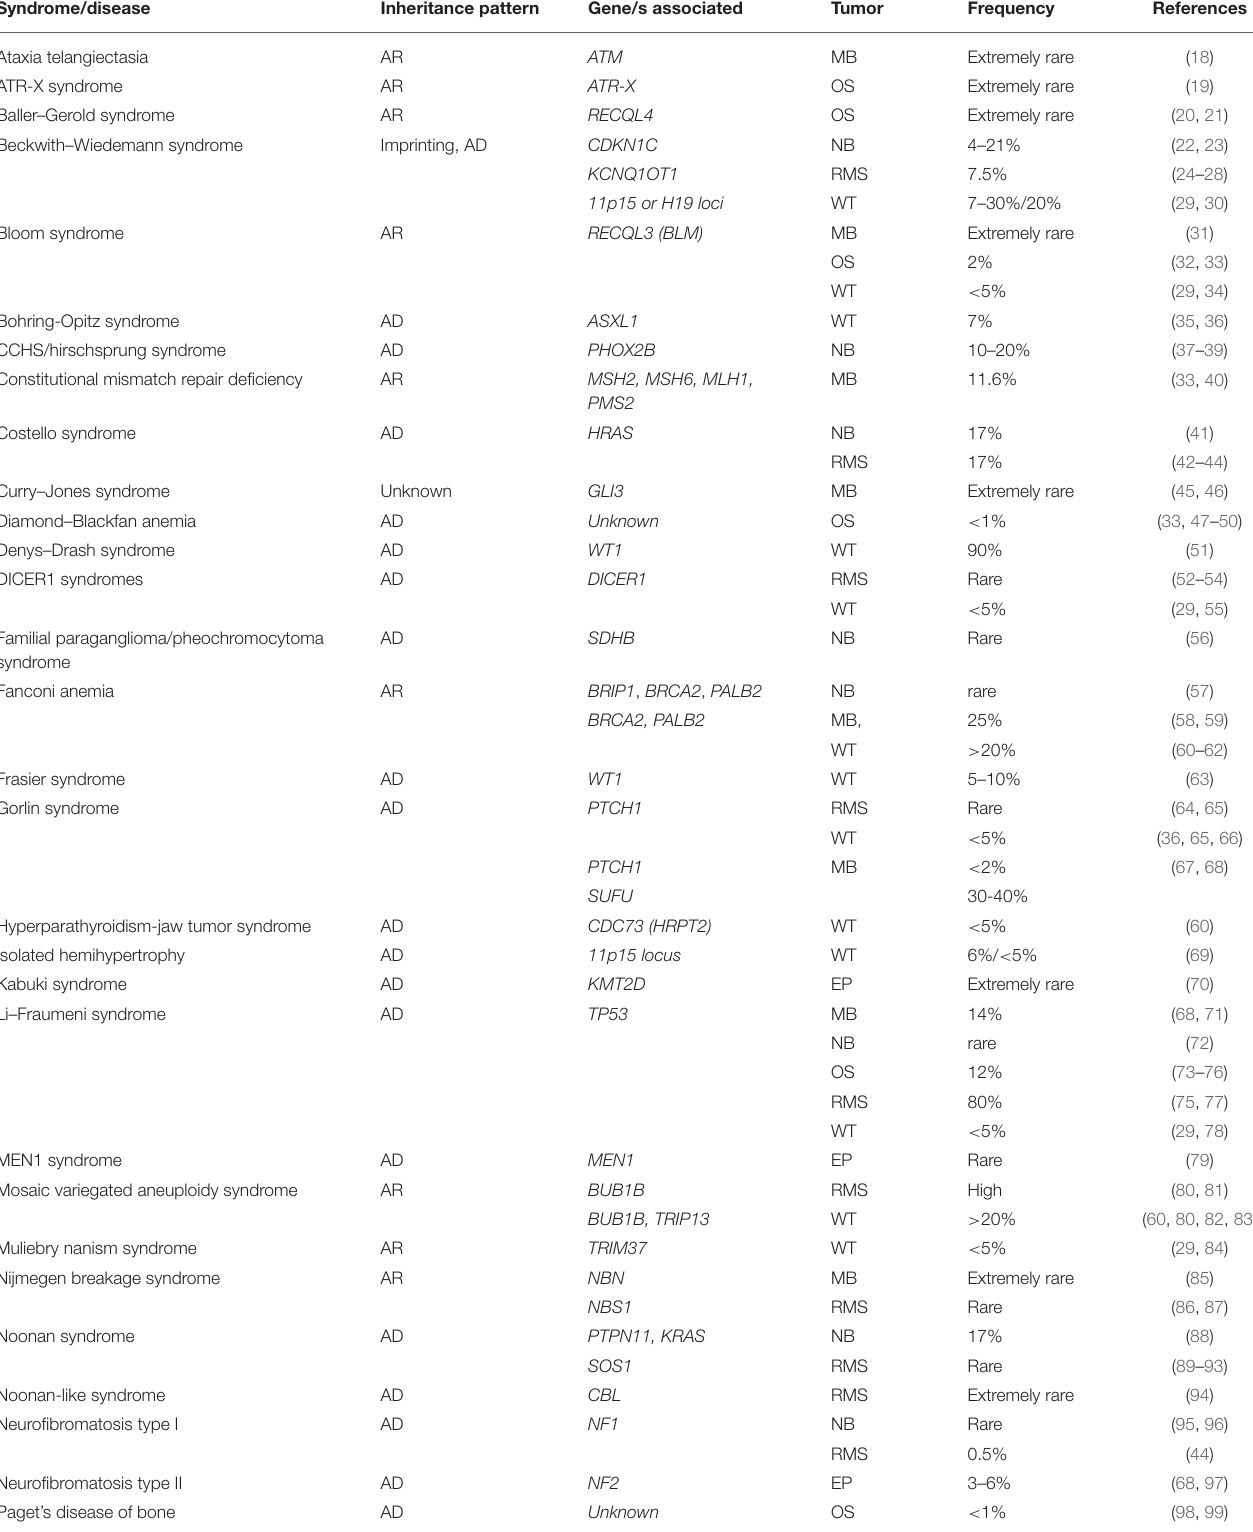
TABLE 2 | Syndromes associated with pediatric tumors. Frequencies reported refer to the occurrence rate of pediatric cancers in patients with genetic